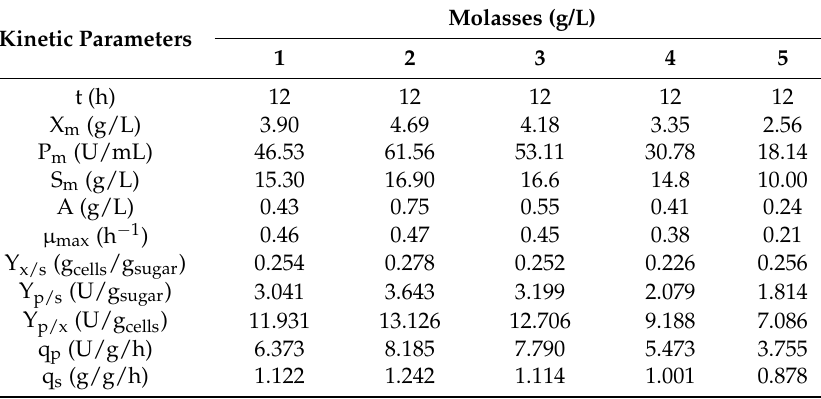
Table 2. Batch Fermentation Kinetics of T1 Lipase Production by Recombinant E. coli Using Different Molasses Concentrations in Shake Flask.